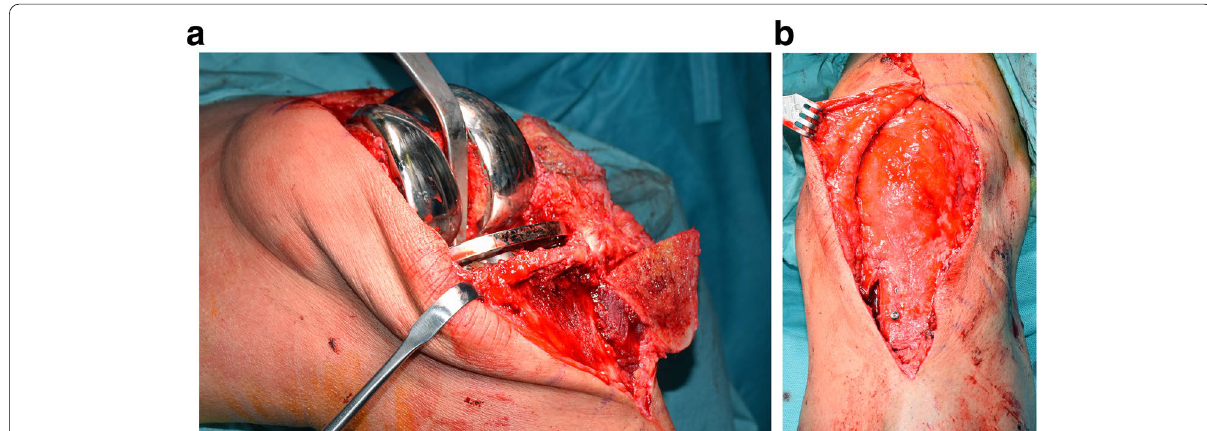
Fig. 1 a Intraoperative presentation of the osteotomy of the tibial tubercle with TKA from the medial side of the anterior edge of the tibial tubercle. b Intraoperative presentation of fixation of osteotomised tibial tubercle with lag